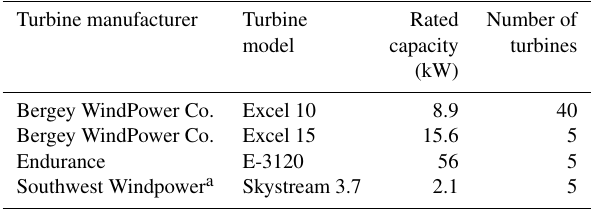
Table 2. Small wind turbine models employed in the